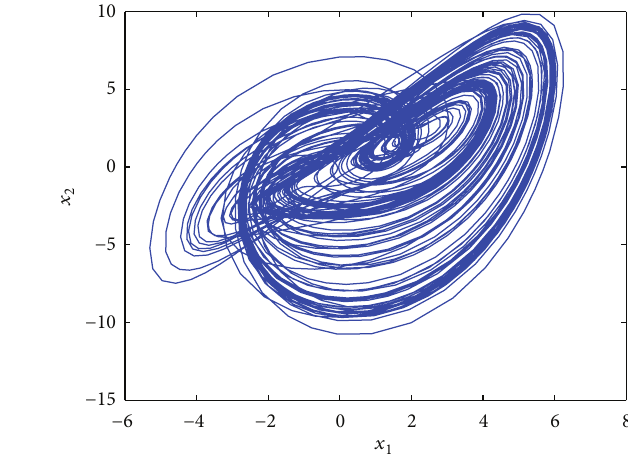
Figure 10: Hyperchaotic attractor in 𝑥 1 − 𝑥 2 plane (𝑢 = 1.5)